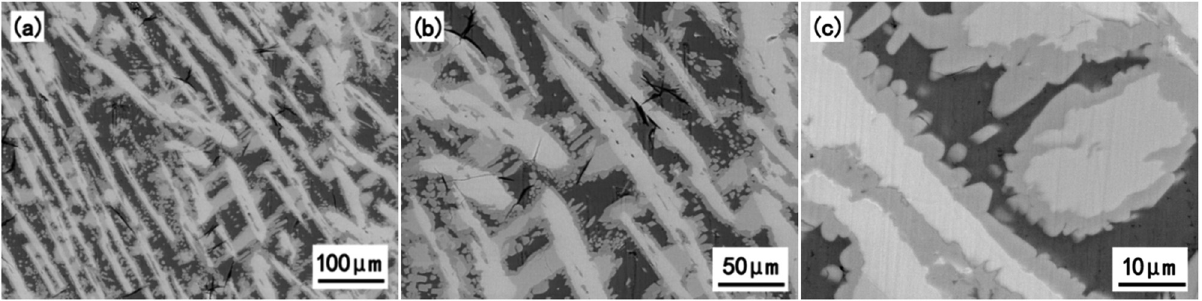
Figure 6: Morphology of Al – Mn – Fe alloy in the as - cast state at di ff erent magni fi cation: ( a ) 500 × , ( b ) 1.00k × , ( c ) 2.00 k × .